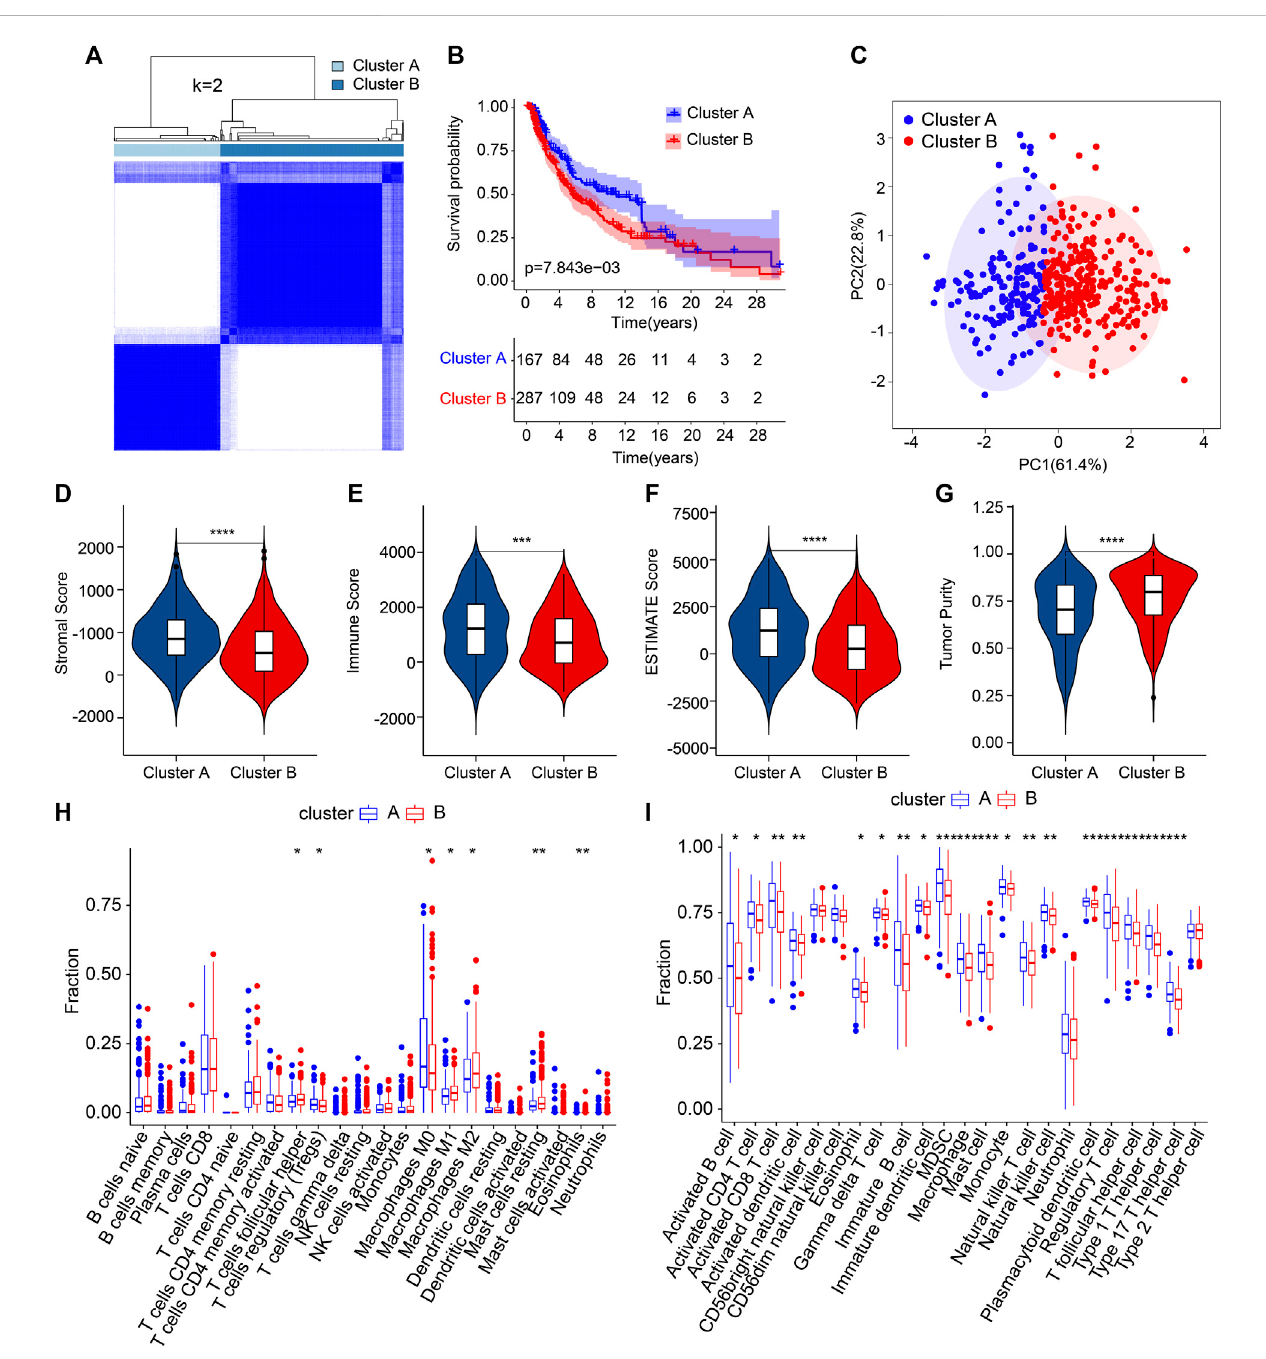
FIGURE 6 The result of consensus clustering and immune in fi ltration landscape analysis in different subgroups. (A) Consensus clustering heatmap demonstrates a suitable classi fi cation of CM samples (K = 2). (B) The Kaplan – Meier survival curve analysis of patients in Cluster A and Cluster B. (C) PCA analysis exhibits a distinction between patients in Cluster A and Cluster B according to the four prognostic ARGs. (D – G) The stromal, immune, and ESTIMATE scores and tumor purityresults. (H) Thefractionof22-typeimmunecellsinClustersAandB. (I) Theproportionof23-typeimmunecellsinClustersAandB.* p < 0.05,** p